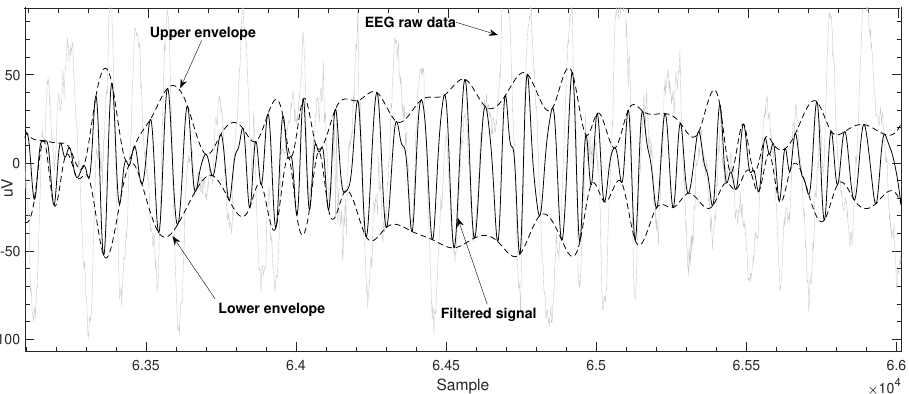
Figure 1. This figure shows an example of the original EEG raw signal, β filtered signal and the respective envelopes using a 20-point spline interpolated max,min